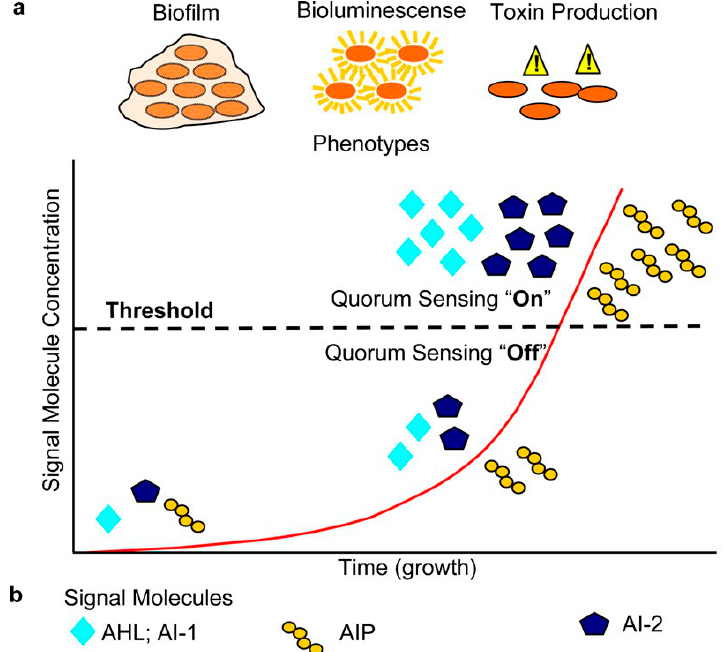
Figure 3. Schematic of the quorum sensing “Switch”, types of signal molecules and phenotypes. Autoinducers synthesis increases with bacteria population density ( b ) and when a thresthold level is achieved the response is activated ( a ) [134]. Reproduced with permission.